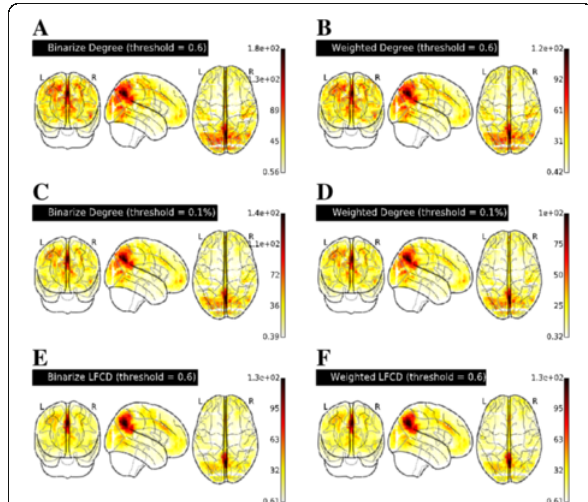
Values are averaged across the 36 datasets and presented along with standard deviations in parenthesis. Impl: Implementation, Thr: Number of threads used to process a single dataset, Mem: average (standard deviation) memory in gigabytes used to process a single dataset, T D : the average (standard deviation) time in seconds to process a dataset. These statistics were collected on a C3.xlarge Amazon Web Services Elastic Compute Cloud node with 8 hyperthreads and 15 GB of RAM